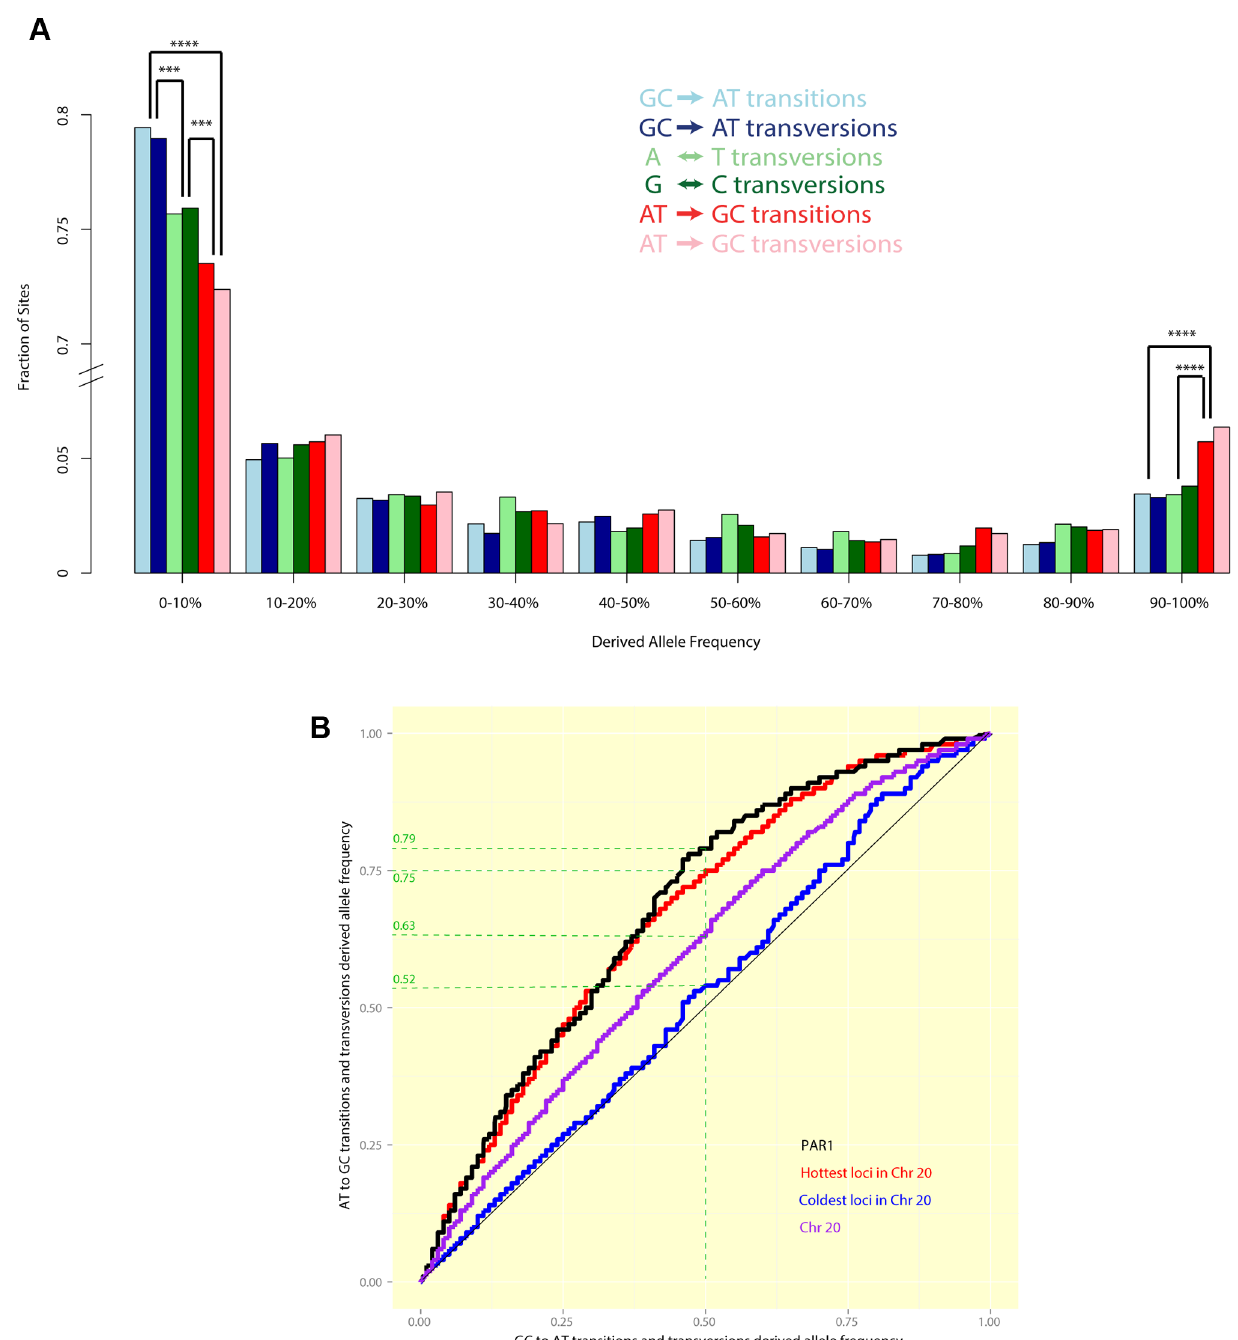
Figure 5. (A) A comparison of allele frequency spectra of different mutation types segregating in humans in PAR1. A significantly greater fraction of GC-increasing mutations have allele frequencies . 90%, while a significantly greater fraction of GC-reducing mutations have allele frequencies , 10%. Differences with P v 10 { 3 are marked (3 asterisks indicate P v 10 { 3 while four indicate P v 10 { 4 ). (B) Quantile-quantile plots show the difference between the allele frequency spectra of GC ? AT mutations (x-axis) and AT ? GC mutations (y-axis) in PAR1 and Chr 20. If both types of mutation had the same allele frequency spectrum, we would expect to see a straight line. Points above the diagonal indicate that AT ? GC mutations are at higher frequencies than GC ? AT mutations, while points below the diagonal show the opposite trend. For example, the green dashed guide lines show that, in PAR1 (black) the same proportion of AT ? GC sites has allele frequencies § 79% as GC ? AT sites with allele frequencies § 50% . This bias towards higher allele frequencies for AT ? GC mutations is significant ( P v 10 { 4 ). It is comparable to the bias in the hottest 15% of loci, 1 kb in size, in Chr 20 (red), which have a sex-averaged rate comparable to that of PAR1 as a whole (8.2 cM/Mb). The coldest 15% of loci in Chr 20 (average rate v 0 : 1 cM/ Mb) do not show a significant elevation of GC allele frequencies ( P ~ 0 : 12 ).